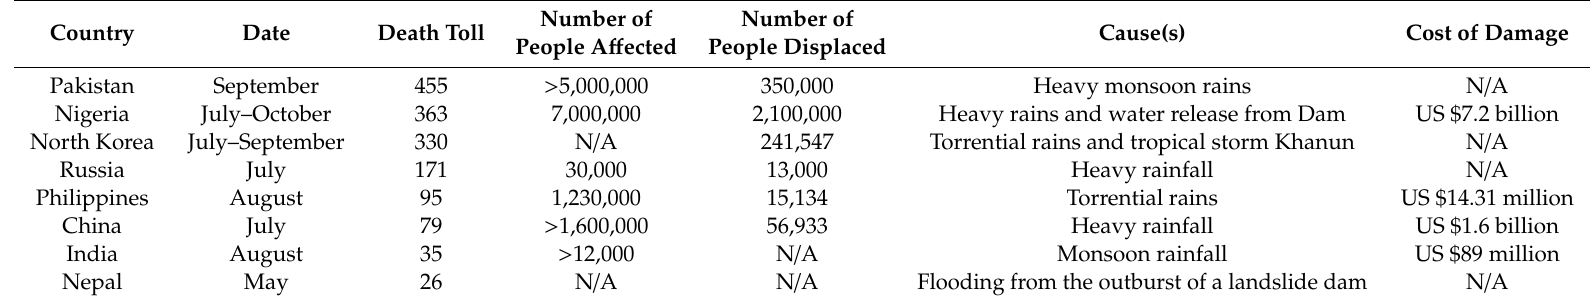
Table 1. Statistics for the most devastating flood disasters in 2012 (compiled by authors based on